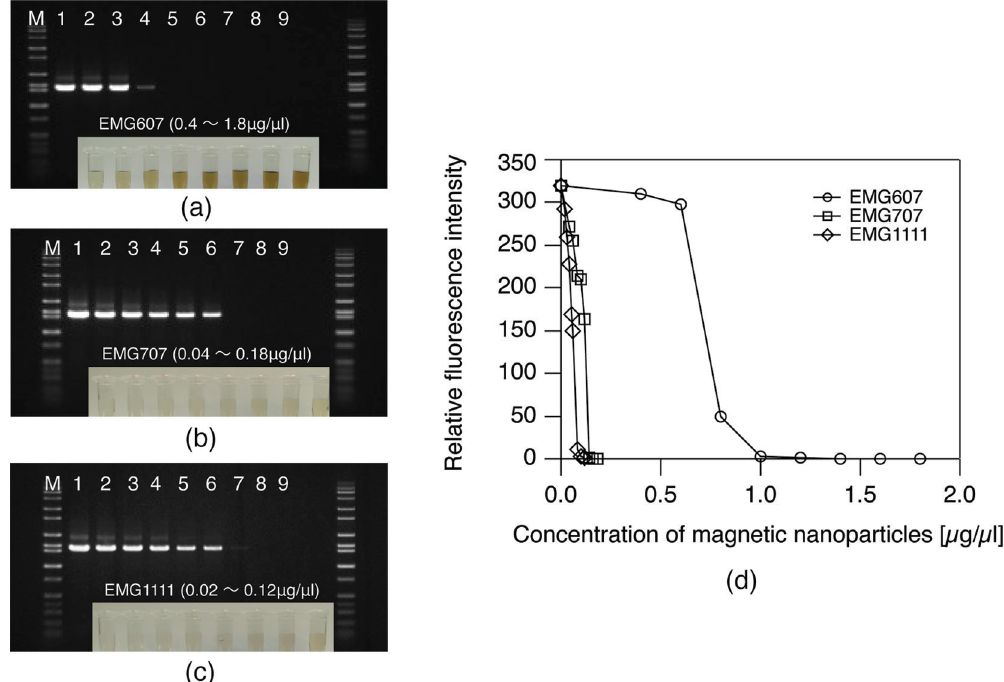
Figure 2. Amplified DNA bands with different concentrations of magnetic nanoparticles observed using agarose gel electrophoresis, each corresponding to the inset photograph of diluted magnetic nanoparticles with the same concentration. ( a ) Lane 1: control without magnetic nanoparticles; lanes 2–9: 0.4, 0.6, 0.8, 1.0, 1.2, 1.4, 1.6 and 1.8 μ g/ μ L of EMG607 magnetic nanoparticles, respectively ( b ) Lane 1: control without magnetic nanoparticles; lanes 2–9: 0.04, 0.06, 0.08, 0.1, 0.12, 0.14, 0.16 and 0.18 μ g/ μ L of EMG707 magnetic nanoparticles, respectively ( c ) Lane 1: control without magnetic nanoparticles; lanes 2–9: 0.02, 0.03, 0.04, 0.05, 0.06, 0.08, 0.1 and 0.12 μ g/ μ L of EMG1111 magnetic nanoparticles, respectively. ( d ) Dependence of PCR product yield on the concentration of the magnetic nanoparticles added to the PCR